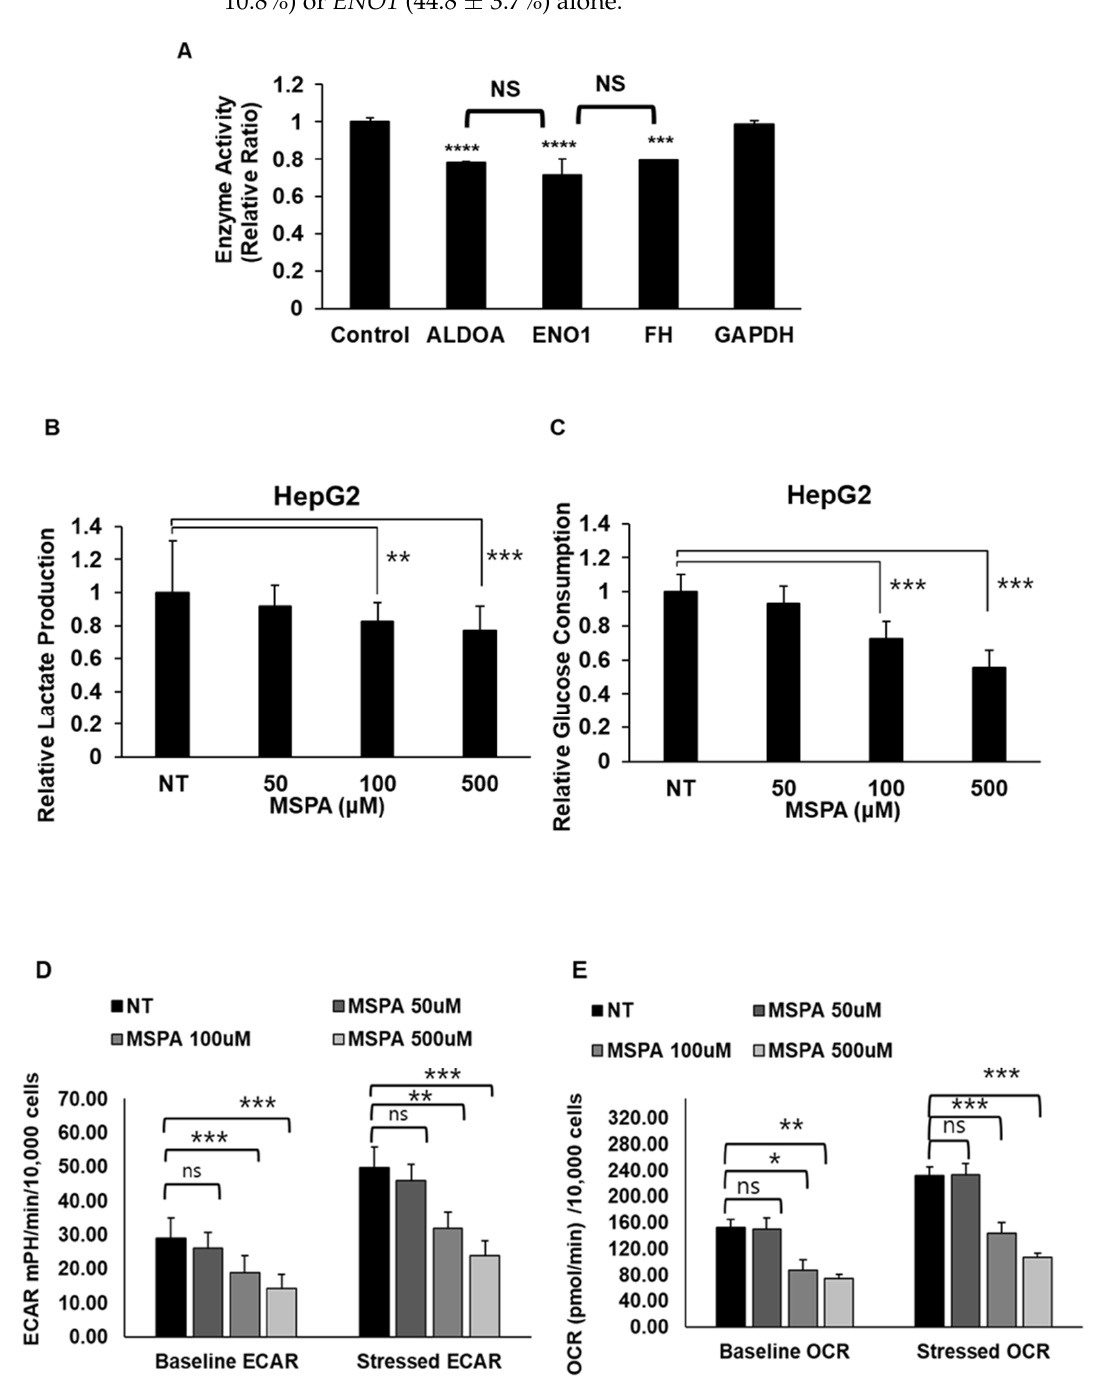
Figure 3. MSPA impairs glycolysis through modifying the enzymes ( A ), measurement of the effect of MSPA on the enzymatic activity of ALDOA, ENO1 , FH , and GAPDH in HepG2 cell lines ( B ), relative lactate production (left) and ( C ), relative glucose consumption (right) in NT (DMSO-treated) and MSPA (50, 100, and 500 uM)-treated HepG2 cells for 72h. ( D ), Extracellular acidification rate and ( E ), oxygen consumption rate in HepG2 cells treated with 50 µ M, 100 µ M and 500 µ M of MSPA for 48 h. Data represent the mean ± SD ( n = 3). * p < 0.05, ** p < 0.01, *** p < 0.001, **** p < 0.0001 versus the control group.